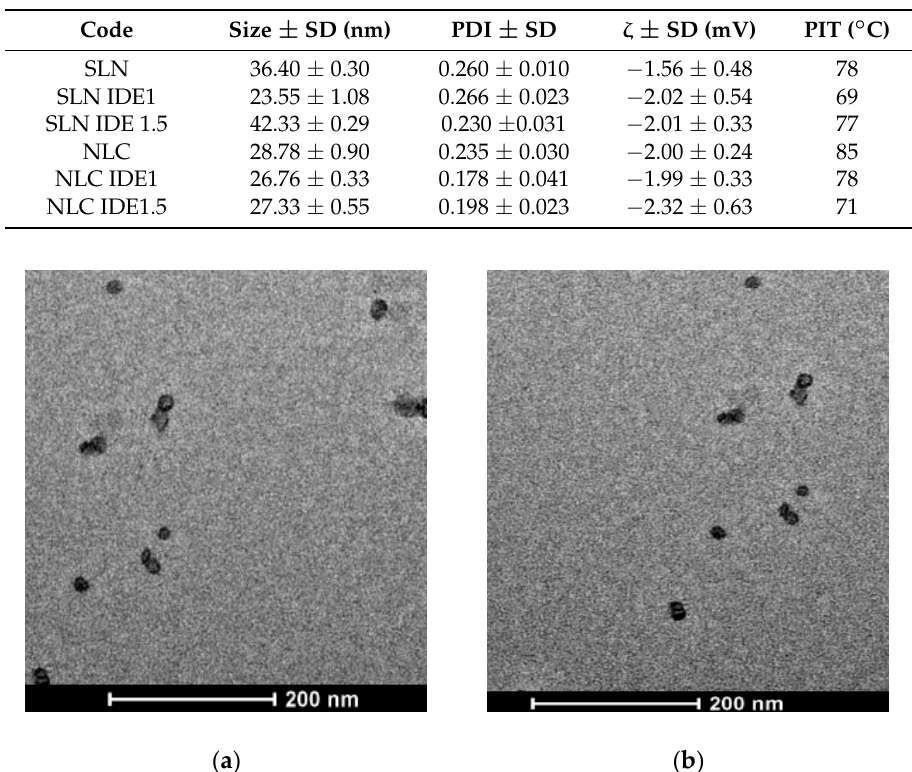
Figure 1. Transmissions electron microscopy (TEM) images of SLN IDE1 ( a ) and NLC IDE1 ( b ). IDE = idebenone, SLN = solid lipid nanoparticles, NLC = nanostructured lipid carriers.